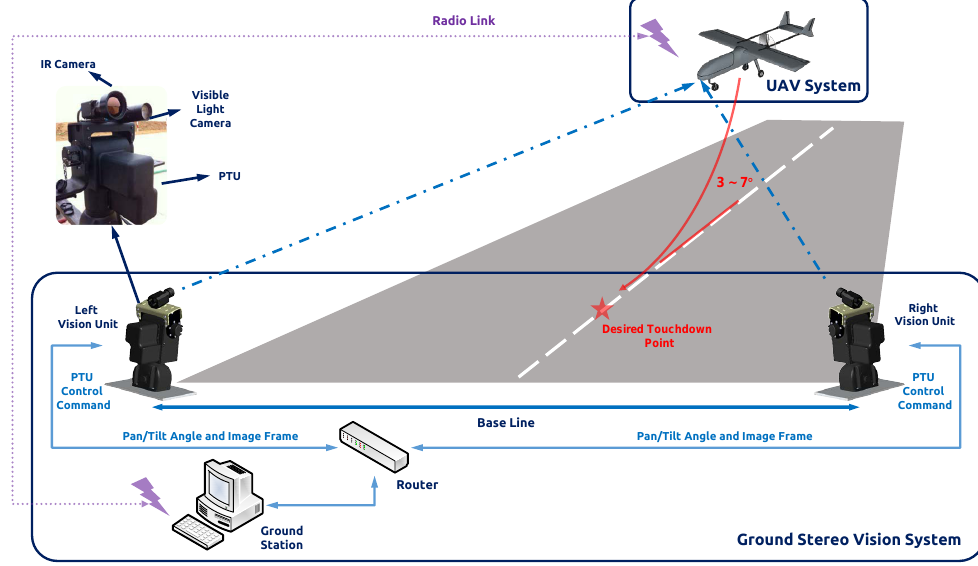
Figure 3. Architecture of the ground stereo vision